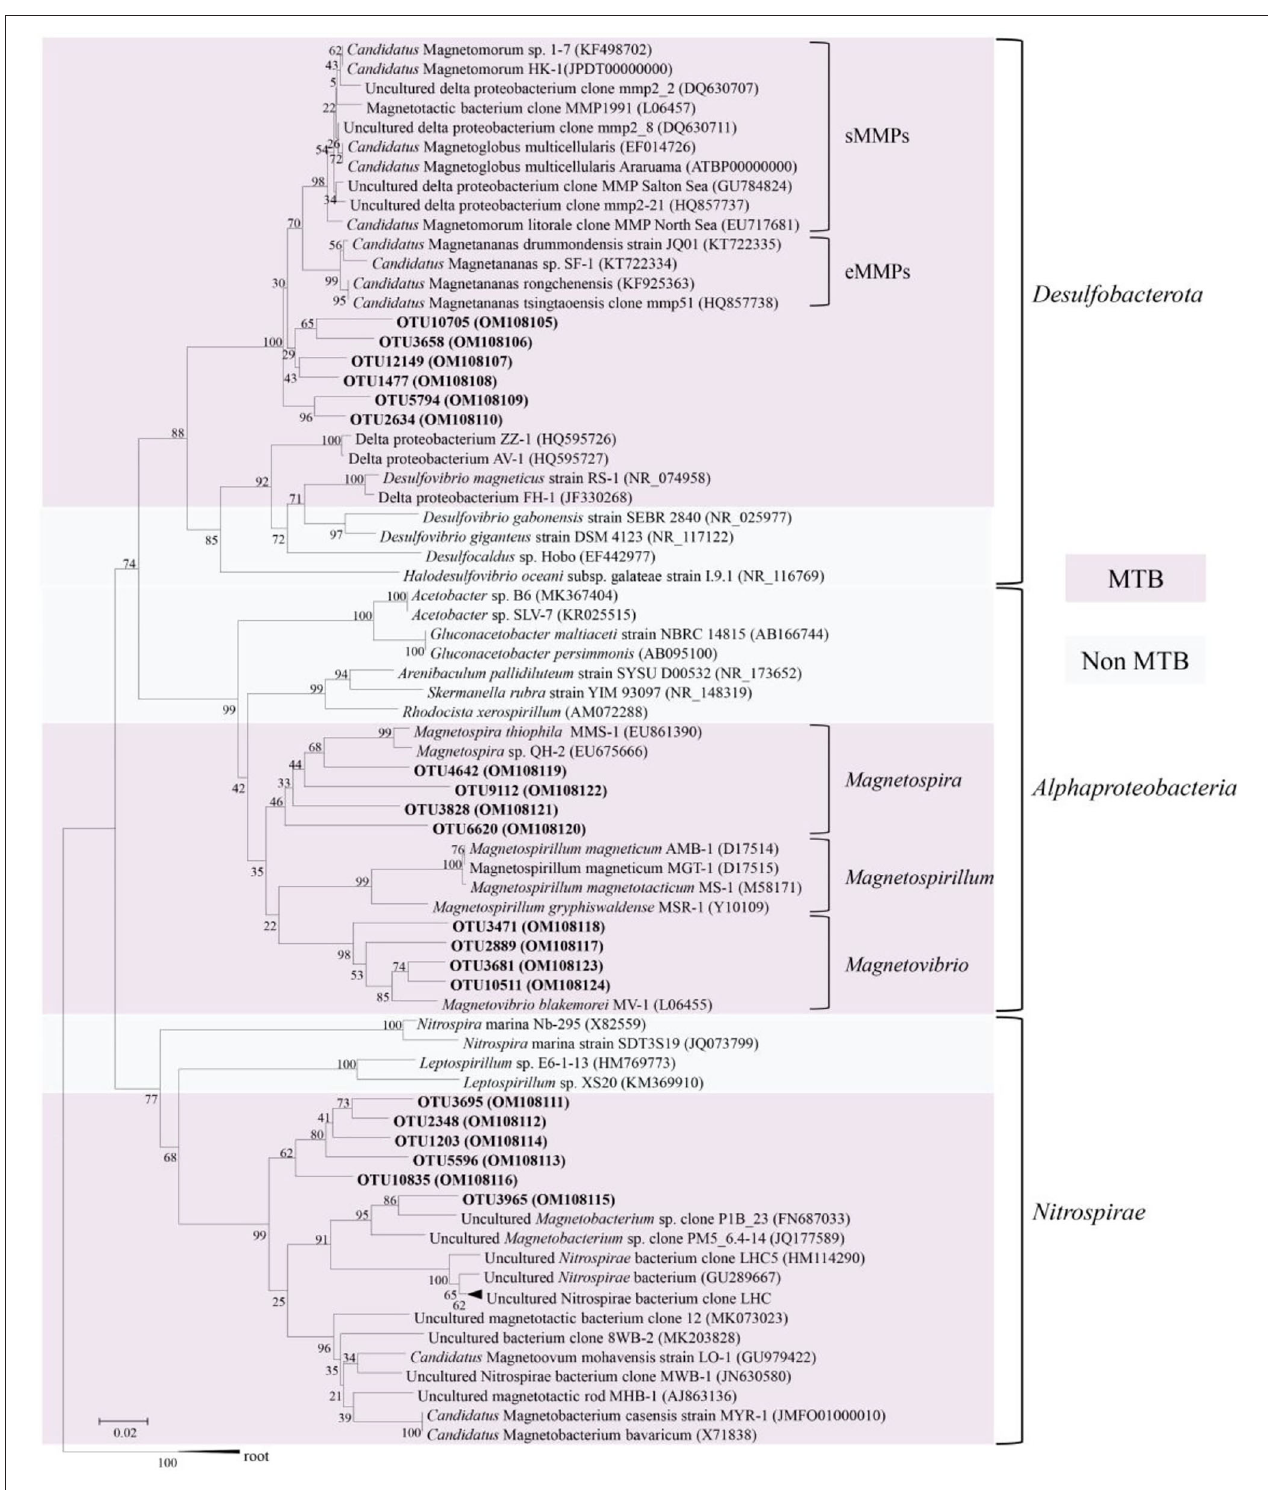
FIGURE 2 | Phylogenetic tree constructed based on 16S rRNA sequence gene reads related to magnetotactic bacteria. The sequences determined in this study are shown in bold text. GenBank accession numbers of the sequences used are indicated in parentheses. Scale bar: 0.02.